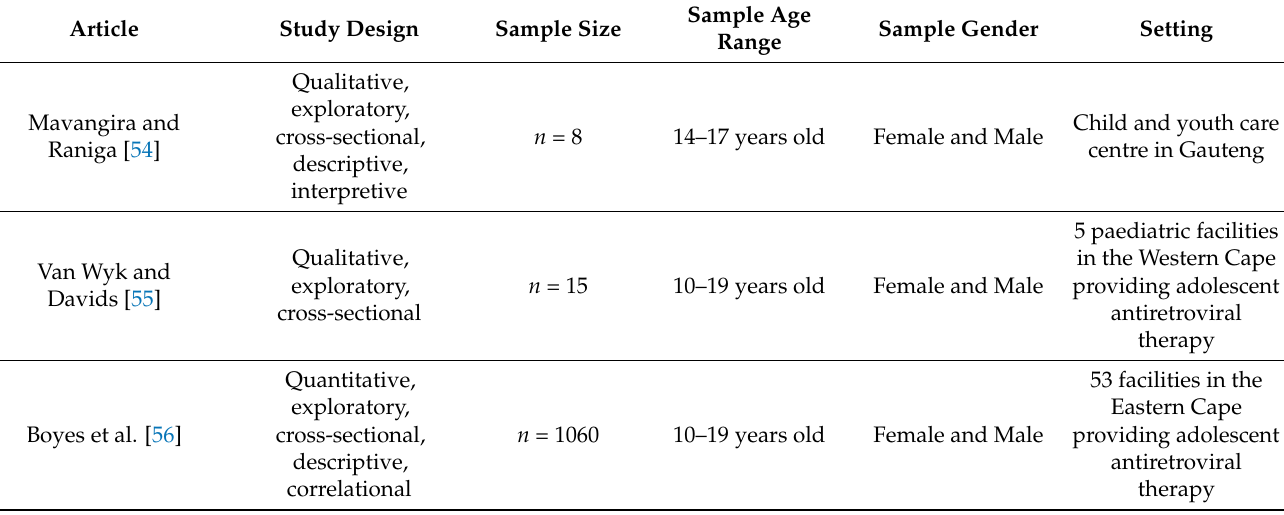
Table 2. Descriptive Overview of the Included